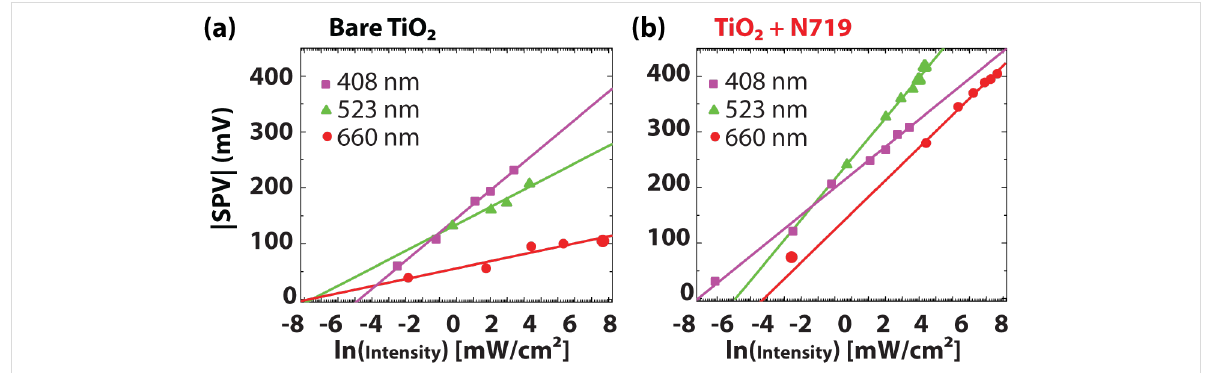
Figure 6: Semilogarithmic plot of the SPV dependence on the incident light intensity, (a) measured for three different wavelengths on bare and (b) N719-sensitized TiO 2 .